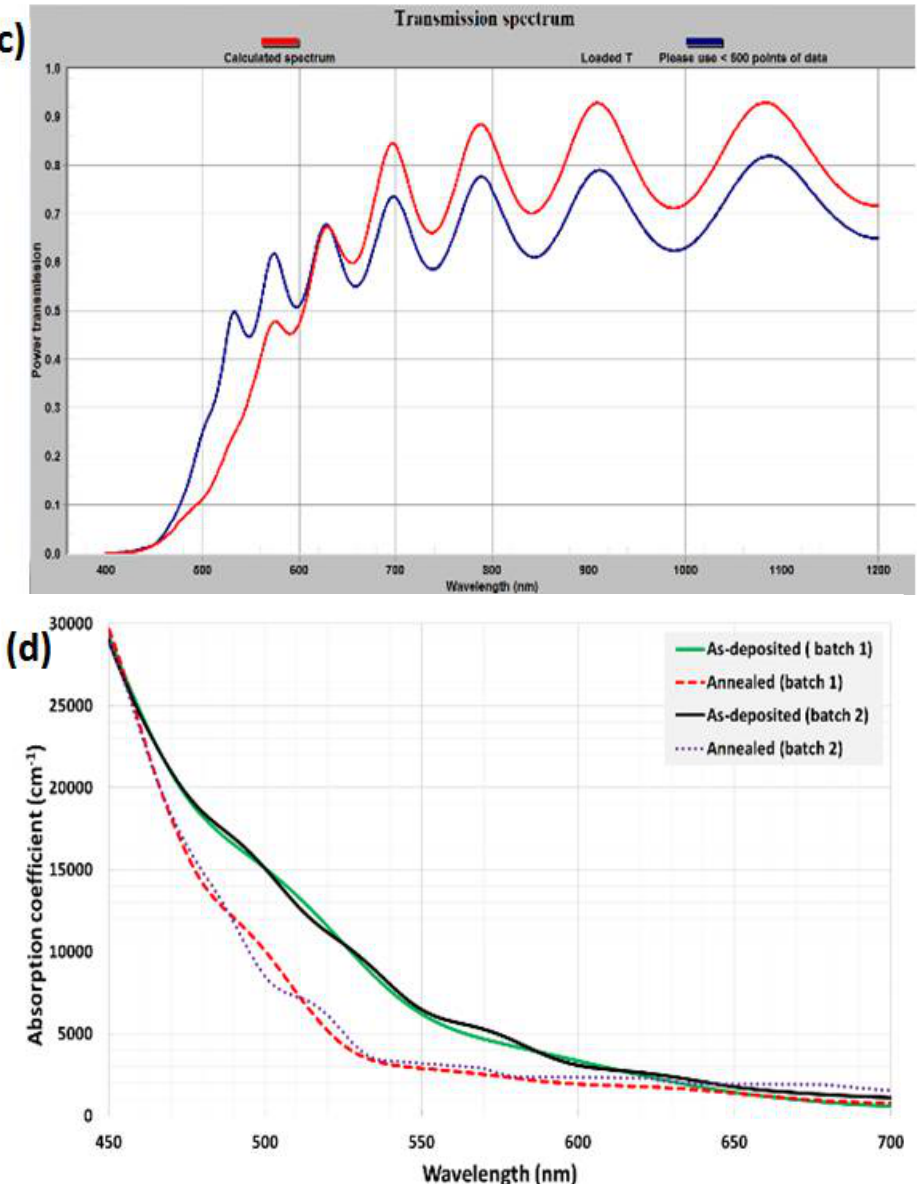
Figure 10. Magneto-photonic crystal (MPC) software fitted transmission spectra of different thin film garnet layers; ( a ) annealed garnet sample from batch-1, ( b , c ) as-deposited and annealed garnet samples form batch-2, ( d ) derived absorption coefficient datasets obtained for the as-deposited and annealed garnet samples.